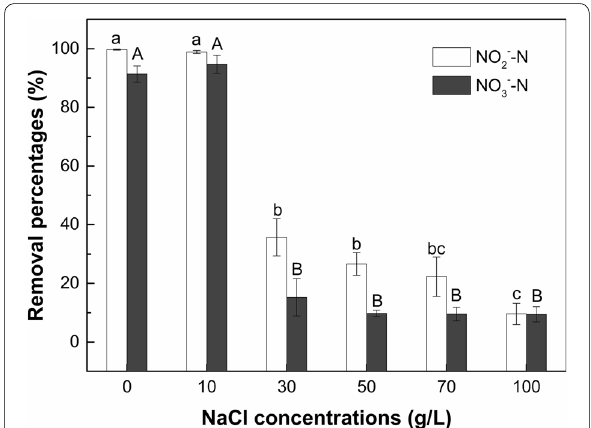
Fig. 4 Removal of NO 2 − –N and NO 3 − –N by strain F1 in denitrification medium with different NaCl concentrations. Values represent the mean of three replicates and error bars represent standard deviations. Columns containing different letters indicate significant differences among treatments at p < 0.05 by Tukey’s test